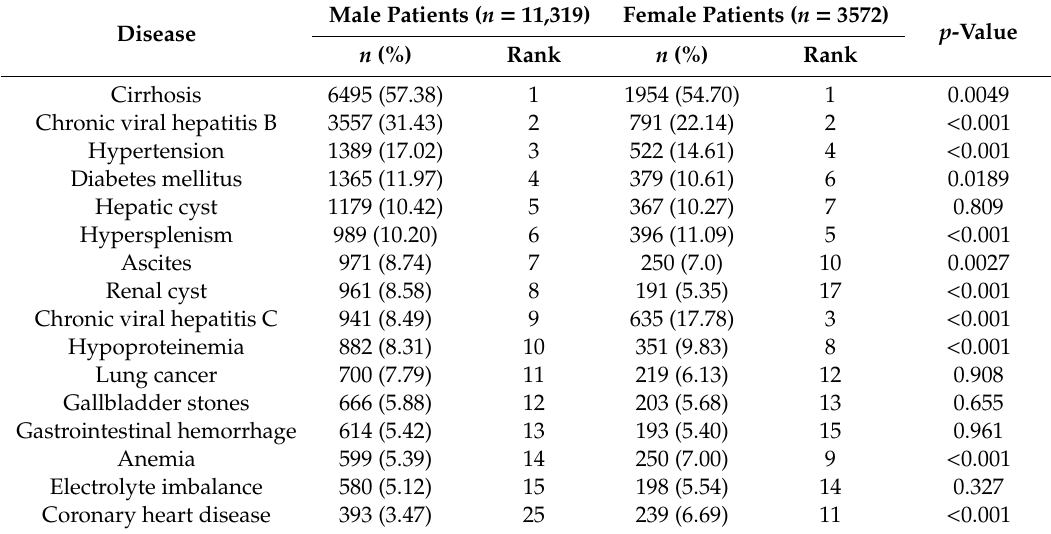
Figure 2. High-frequency comorbidities in patients with HCC. Table 2. Comorbidity prevalence and comparison between male and female patients with